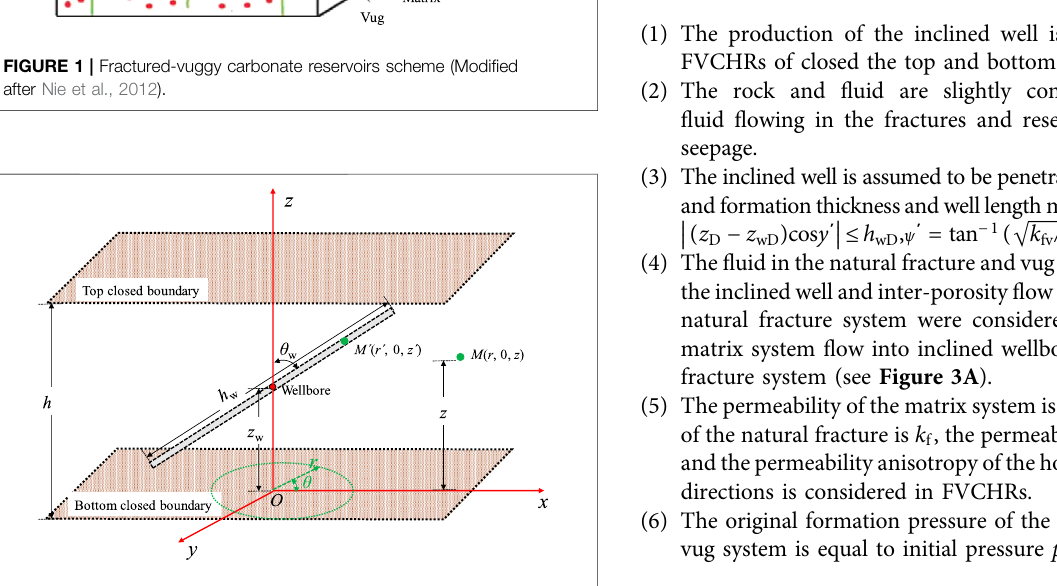
FIGURE 2 | The scheme of an inclined well (Modi fi ed after Dong et al., 2018).